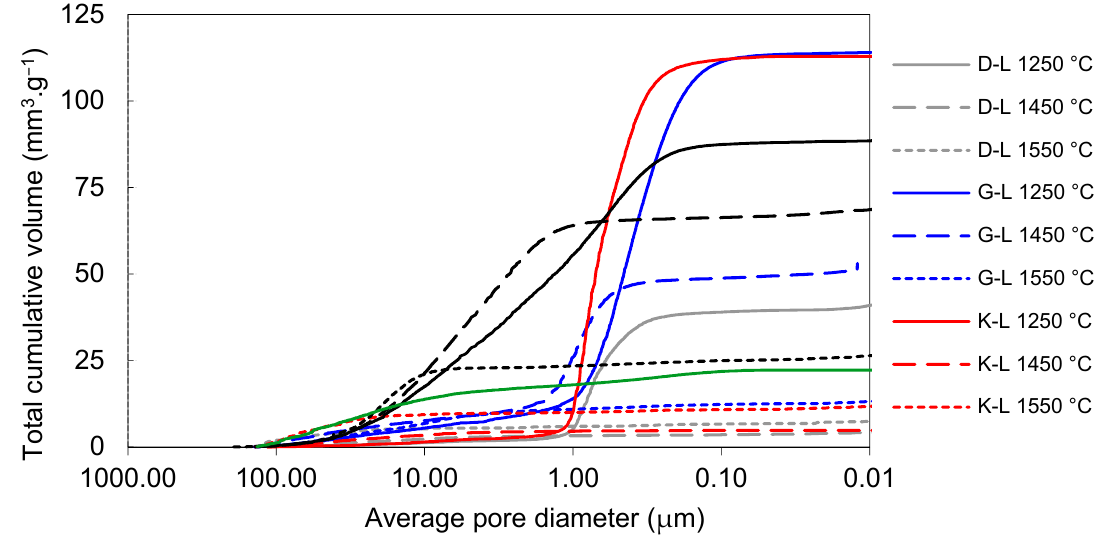
Figure 6. Total cumulative pore volume of laboratory prepared samples and reference material.